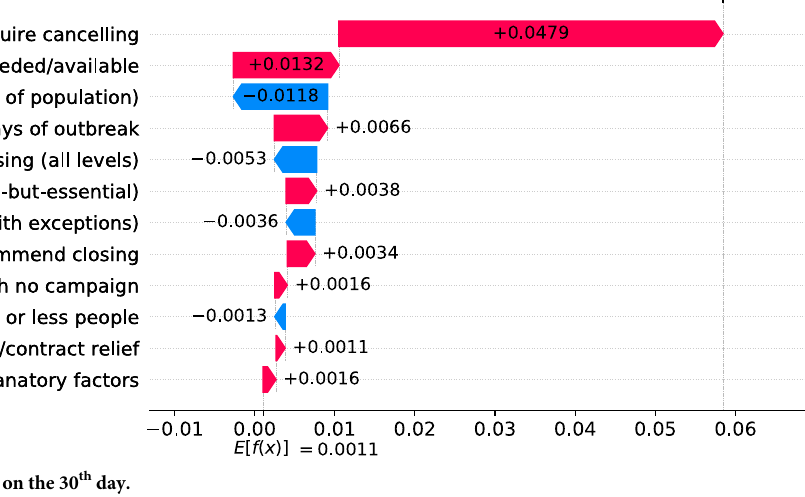
Fig 18. (Color online) factors driving acceleration in the UK on the 30 th